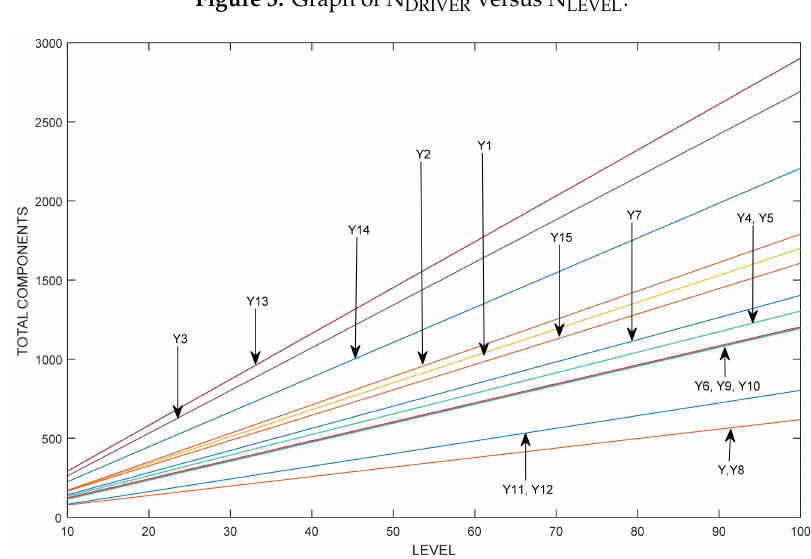
Figure 4. Graph of N TOTAL versus N LEVEL